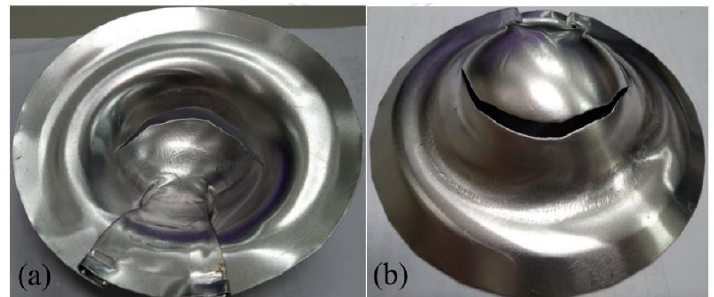
Figure 10. Deep drawing of Al 6061-composite sandwich with 140 °C preheating: ( a ) front view, ( b ) back view.